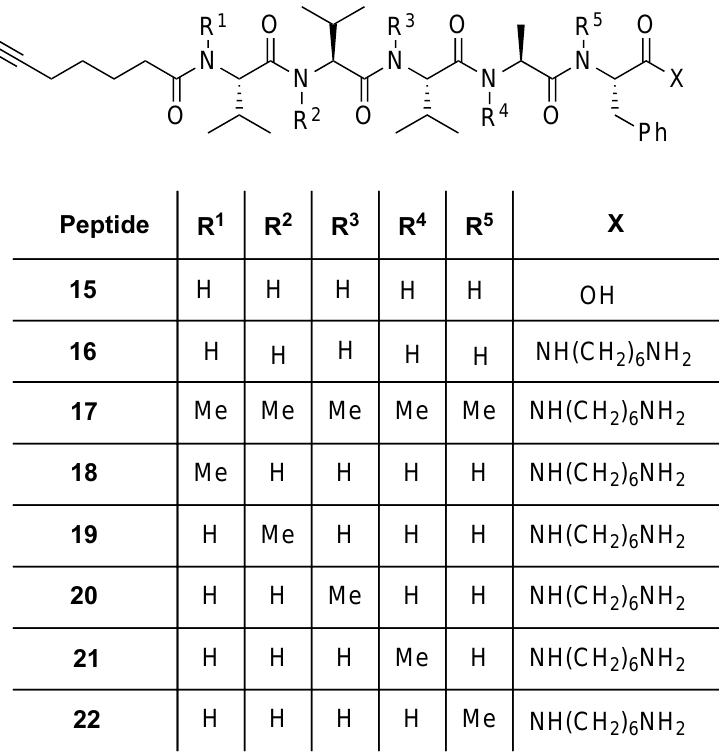
Figure 2. N -Methyl scan of almiramide analogs.